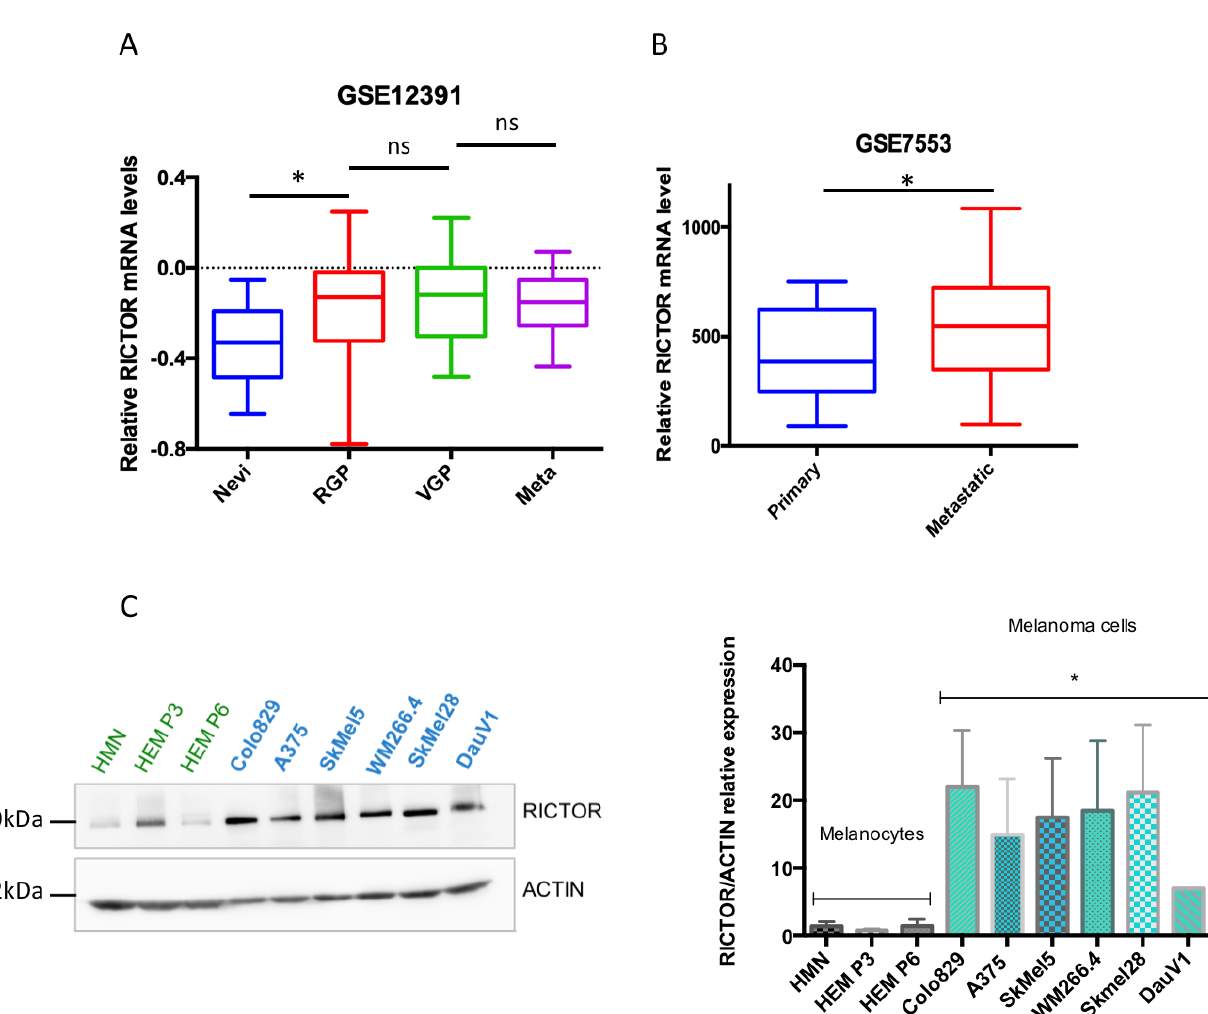
Figure 1. RICTOR expression in human melanocytes and melanoma cells and tissues. ( A ) Bio-informatic analysis of RICTOR expression at the mRNA level in human nevi (Nevi; n = 31), radial growth phase (RGP; n = 11), vertical growth phase (VGP; n = 25), and metastasis melanoma (Meta; n = 5). GSE12391 raw data were compared using the Mann–Whitney test. * p < 0.05. ( B ) Bio-informatic analysis of RICTOR expression at the mRNA level in human primary melanoma (Primary; n = 14) and metastasis melanoma (Metastatic; n = 40). GSE7553 raw data were compared using the Mann–Whitney test. * p < 0.05. ( C ) RICTOR protein expression was assessed by Western blotting in melanocytes (three independent donors, in green) and six melanoma cell lines mutated on BRAF (in blue). β -Actin served as a loading control. RICTOR protein expression was quantified on three independent experiments and normalized with β -Actin expression. The graph represents the means ± s.d. RICTOR expression in the three melanocytes cell lines was compared to its expression in the six melanoma cell lines using the unpaired Student’s t -test: * p = 0.0022.